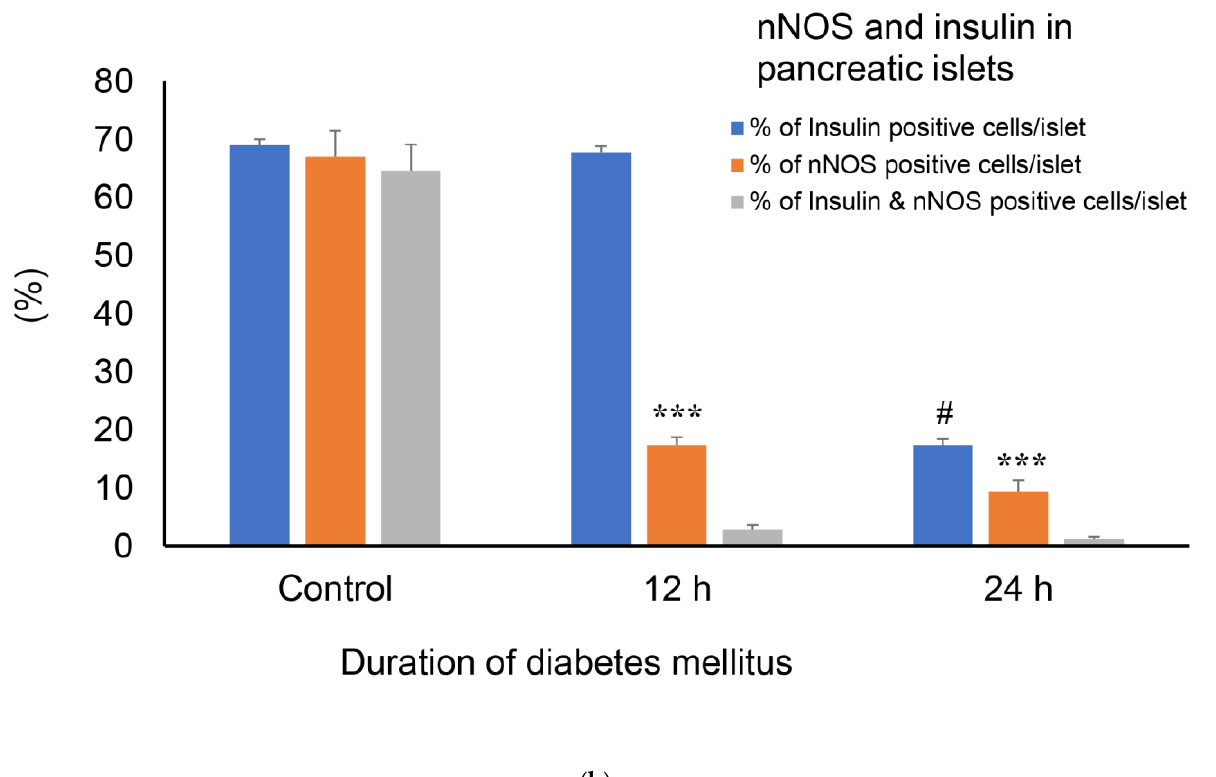
Figure 3. ( a ) shows insulin- (green) and nNOS-(red)-immuno-positive cells in rat islet of Langerhans of control and 12 h and 24 h after induction of diabetes. Note that nNOS co-localized (yellow color of merged image) with insulin in the islet of Langerhans in control, non-diabetic rats. No co-localization was observed after the induction of diabetes. nNOS-immuno-reactive nerve fibres (arrow head) were observed in both the endocrine and exocrine pancreas. Scale bar = 10 μm. ( b ) shows morphometric analysis of insulin- and nNOS-positive cells in the islet cells of the endocrine pancreas. Note that most of the insulin-containing cells in the control rat pancreas also contain nNOS. However, the induction of diabetes was associated with a significant (*** p < 0.001) decrease in the number of nNOS-positive cells in the islet cells of the endocrine pancreas. The number of insulin-positive cells in pancreatic islets also decreased markedly (# p < 0.001 when compared to those of control rats (n = 6)).